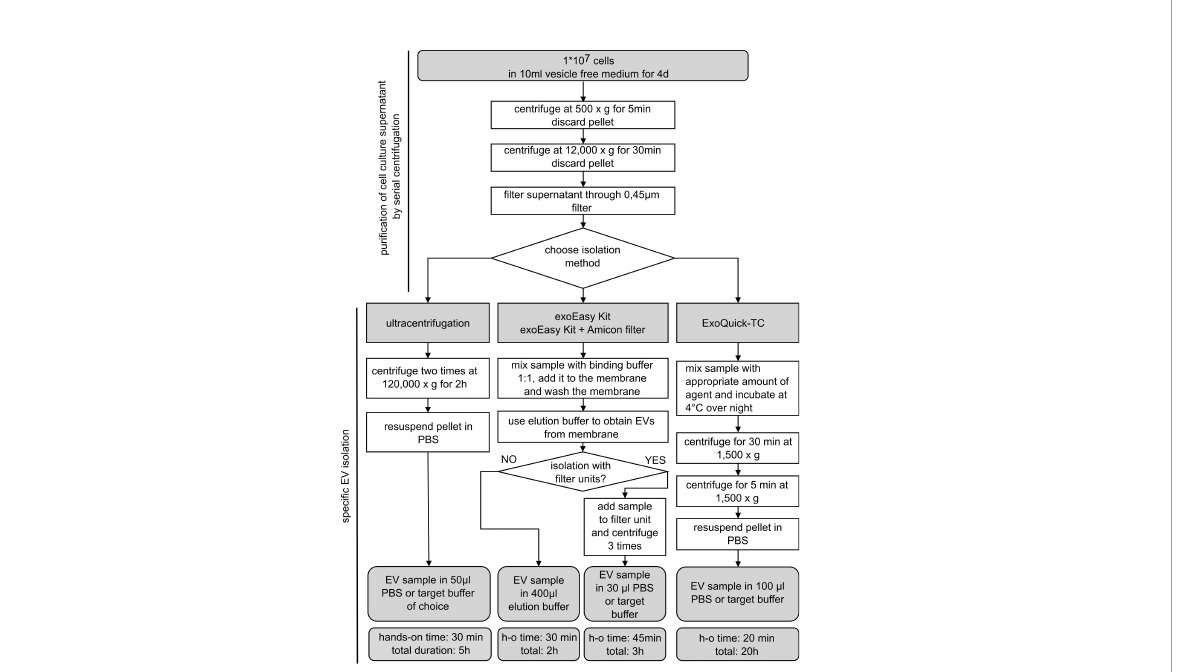
FIGURE 1 Schematic overview of EV isolation procedures. Extracellular vesicle (EV) isolation from MOLM-13 cells and human AML cells using different commonly used EV isolation methods. Cells were cultured for 4 days in vesicle-free FBS prior to harvesting conditioned medium. Samples were puri fi ed by two centrifugation steps and fi ltering through a 0.45-µm membrane. The puri fi ed supernatant was processed by four different isolation methods as depicted in the fl owchart. d, days; h, hours; h-o, hands-on; min,